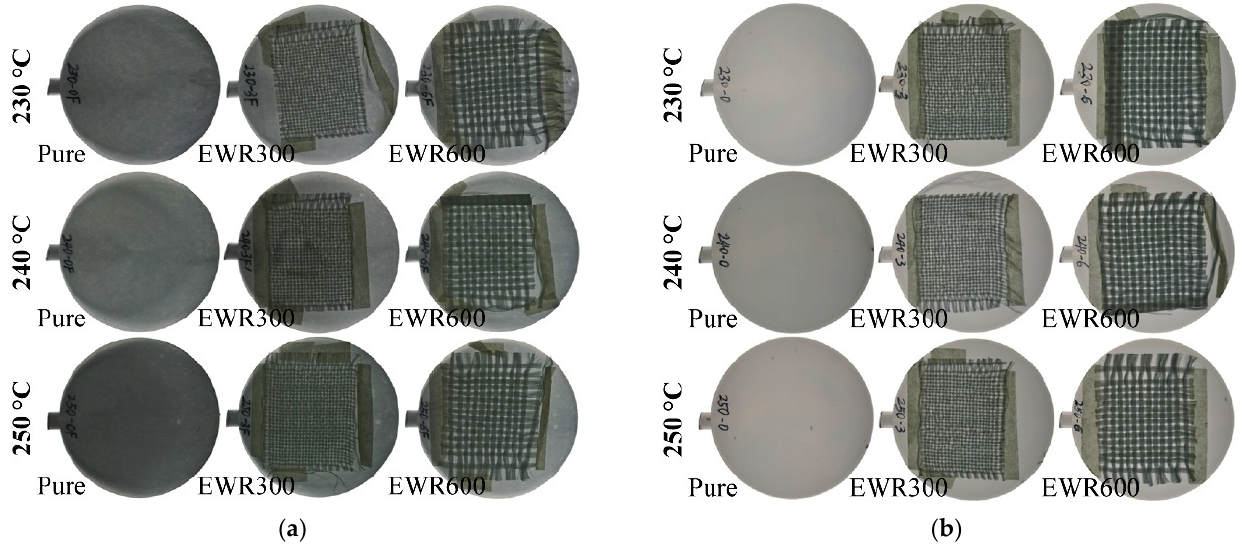
Figure 4. Pictures of the foamed samples ( a ) and unfoamed samples ( b ) under backlighting.